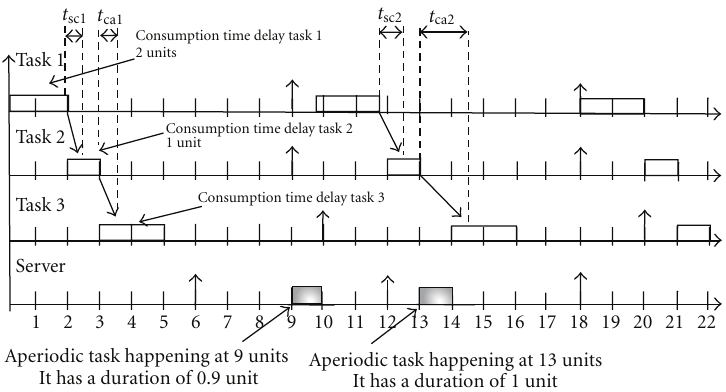
Figure 3: Related time delays are depicted according to both scenarios.